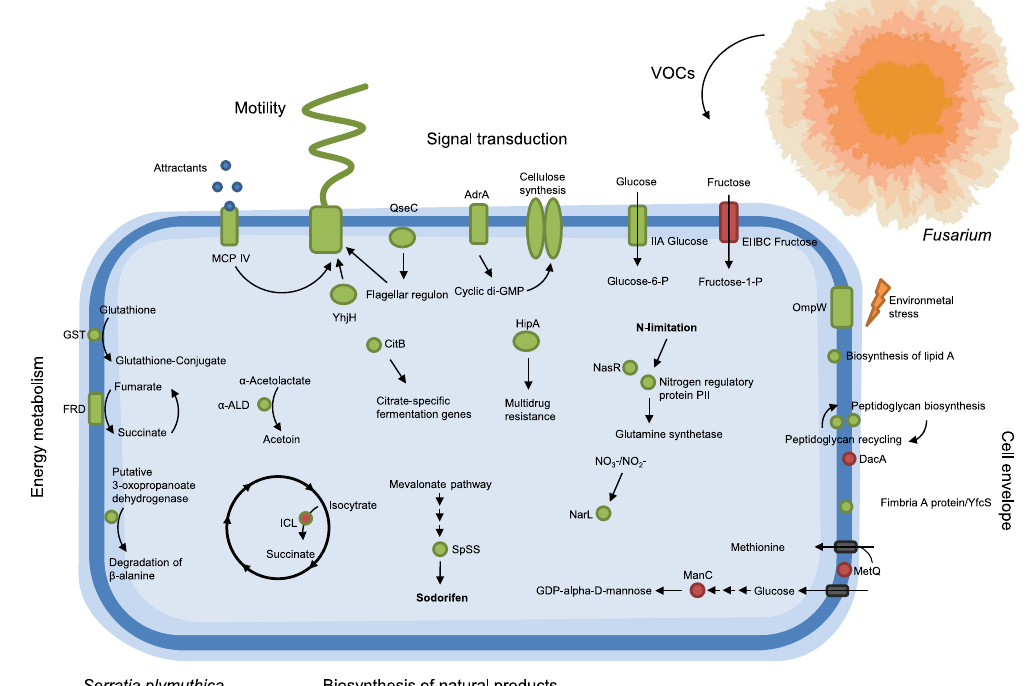
Figure 8. Schematic overview of the most important changes in S. plymuthica PRI-2C transcriptome and proteome in response to fungal VOCs. The overview includes genes and proteins involved in major pathways that have been detected in this analysis and genes and proteins whose amounts were either decreased (red) or increased (green) after exposure to fungal